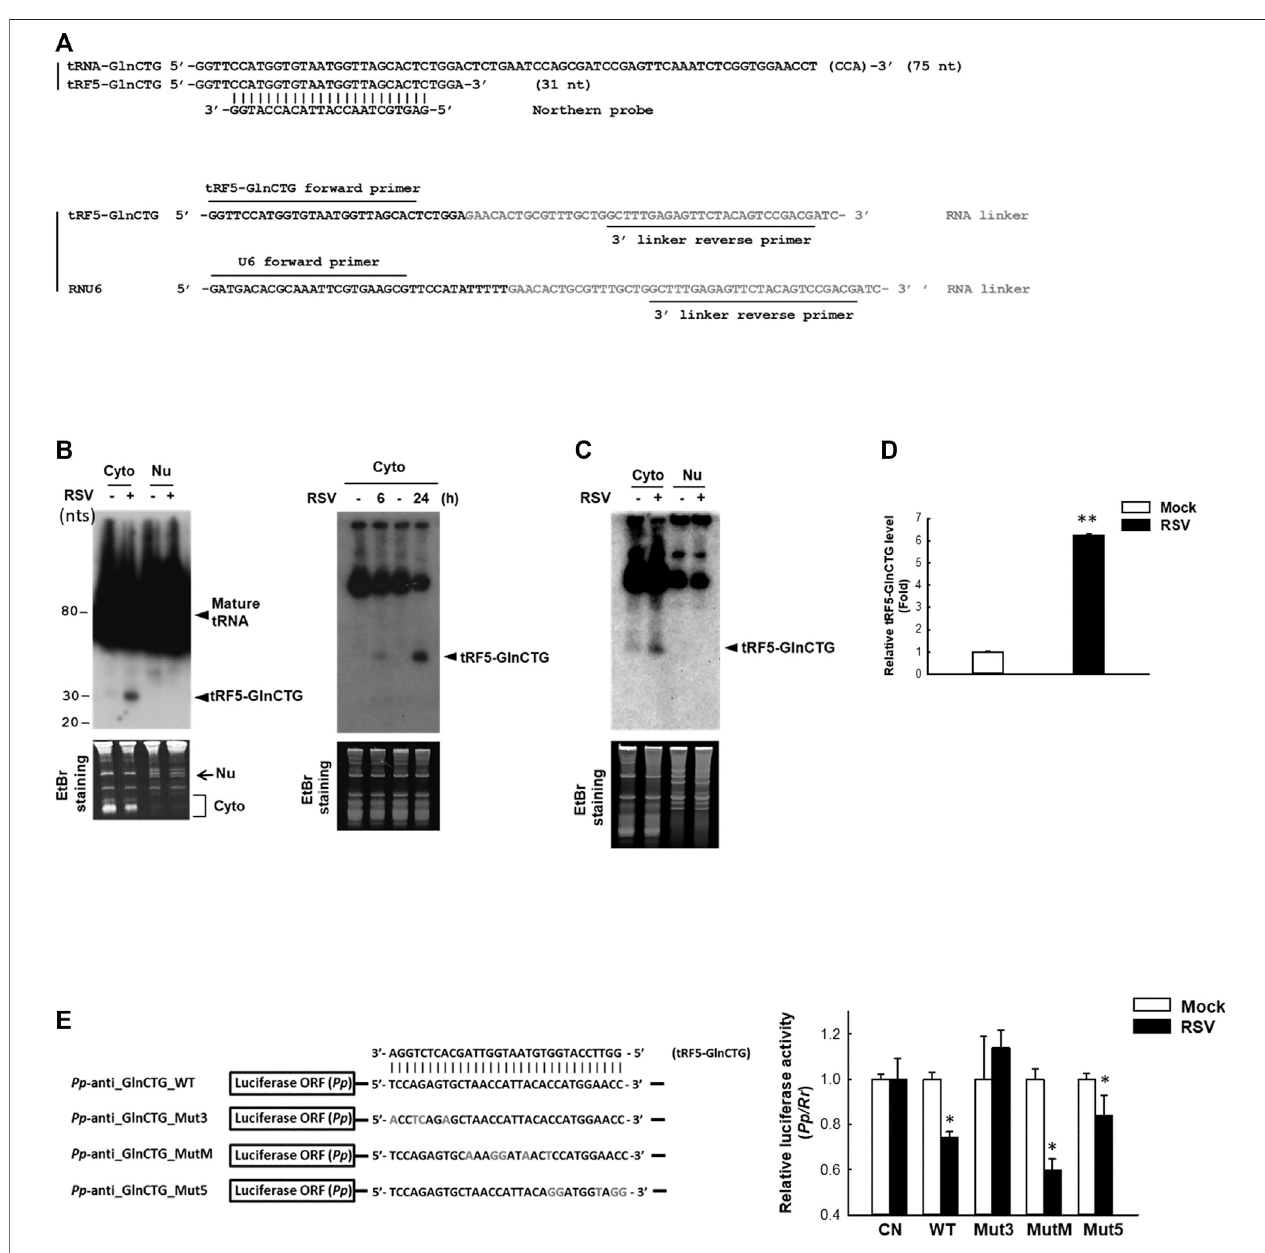
FIGURE 2 | Experimental validation and characterization of tRF5-GlnCTG. (A) Sequence alignment of tRF5-GlnCTG with its parental mature tRNA and Northern probe (upper panel), and the illustration of primers and the 3 ’ RNA linker for tRF detection by qRT-PCR (lower panel). (B) A549 cells were mock- or RSV-infected at an MOIof1.Cytoplasmic(Cyto)andnuclear(Nu)RNAswerepuri fi edat24 hp.i.(leftpanel)orCytoRNAswerepreparedat6and24 hp.i.(rightpanel),followedbyNorthern hybridization to detect tRF5-GlnCTG using the probe indicated in (A) . Ethidium bromide (EtBr) staining is shown for equal loading. The size of tRF5 and mature tRNA is indicated on the right; molecular size markers are indicated on the left. Data are representative of 2 – 3 independent experiments. (C) SAE cells were mock- or RSV-infectedatanMOIof1for15 h,followedbyCytoandNuRNApreparation andthenNorthernhybridizationtodetecttRF5-GlnCTGusingtheprobeindicatedin (A) . EtBrstainingisshownforequalloading.Dataarerepresentativeofthreeindependentexperiments. (D) A549cellsintriplicateweremock-infectedorinfectedwithRSVat an MOI of1for24 h, followedby CytoRNA preparation and then qRT-PCR forthedetection oftRF5-GlnCTG.The tRF5-GlnCTGvalue wasnormalized tothatofRNU6. Thesequenceofforwardandreverseprimersareindicatedin (A) and SupplementaryTableS1 .Dataarerepresentativeofthreeindependentexperiments. ** P < 0.01, relative to the white bar. (E) Left panel: Sequence alignment of tRF5-GlnCTG with a sensor plasmid containing targeting sequence of tRF5-GlnCTG ( Pp - anti_GlnCTG_WT) and three mutant luciferase sensor plasmids (Mut3, MutM, and Mut5). Mutated nts are in red. Right panel: A549 cells in hexaplicate were co- transfected with indicated Pp luciferase sensor plasmids and internal control renilla luciferase plasmids ( Rr ). A sensor plasmid lacking the target site ( Pp -anti_Control vector or CN) was used as a negative control. At 6 h post-transfection, cells were mock- or RSV-infected at an MOI of 1 and then harvested at 24 h p.i. to measure luciferase activities. The relative luciferase activity ( Pp / Rr values) was calculated. Data are representative of three independent experiments. * P < 0.05, relative to the paired white